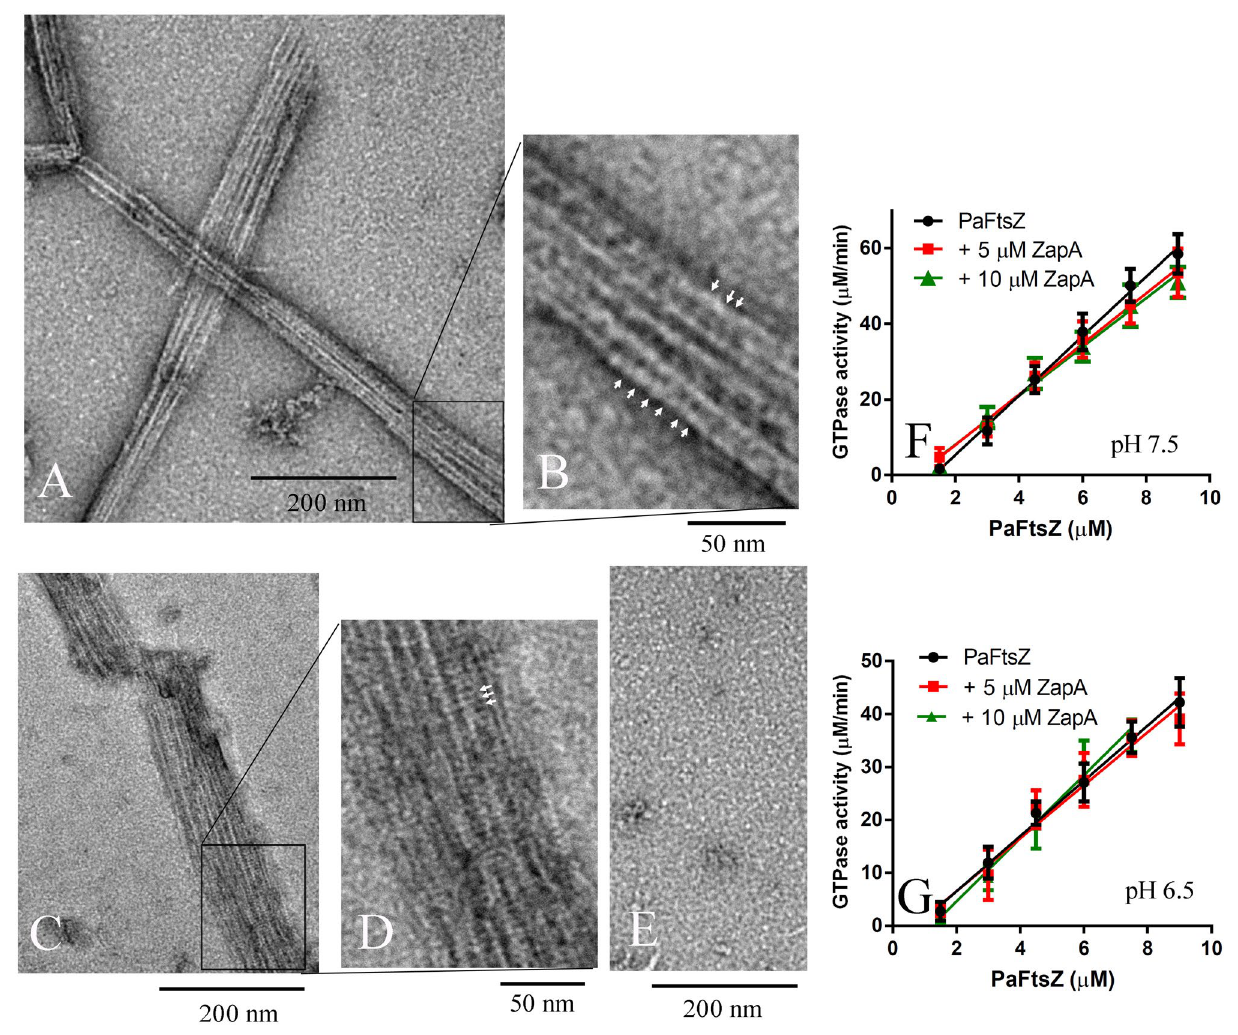
Figure 3. PaFtsZ assembly in the presence of ZapA. (A–E) shows negative stain EM of 5 µM PaFtsZ and 10 µM ZapA in MMK buffer (A,B) , MEK buffer (C,D) , and HEK buffer (E) . The arrows in (B,D) show periodic striations that be due to ZapA crosslinks. (F,G) show the GTPase activity of PaFtsZ with ZapA in HMK buffer (F) and MMK buffer (G) .